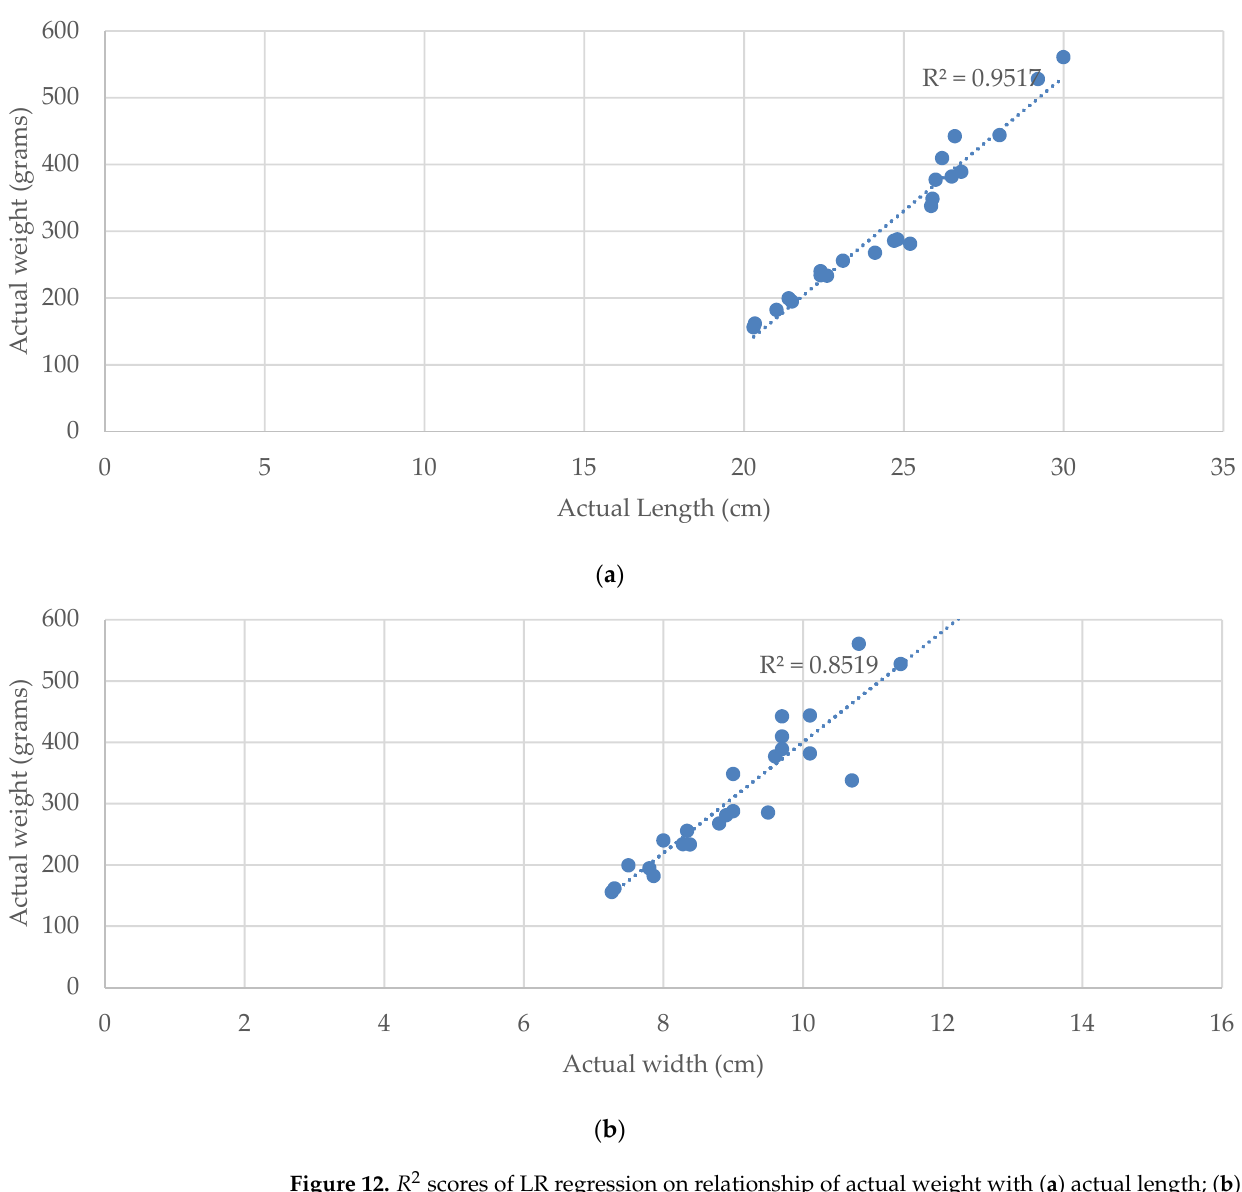
Figure 12. R 2 scores of LR regression on relationship of actual weight with ( a ) actual length; ( b ) actual width.